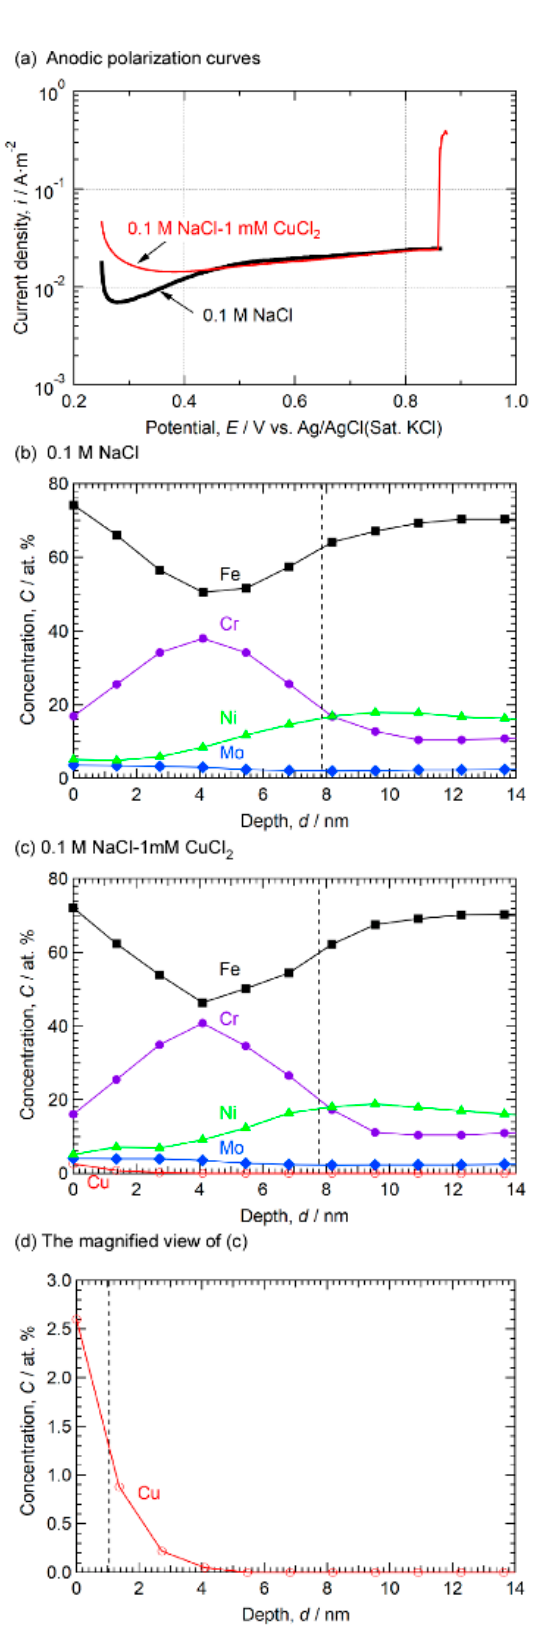
Figure 6. ( a ) Anodic polarization curves polarized from 0.25 to 0.86 V in 0.1 M NaCl and 0.1 M NaCl-1 mM CuCl 2 . Composition depth profiles of the surfaces for the specimens polarized ( b ) in 0.1 M NaCl and ( c ) in 0.1 M NaCl-1 mM CuCl 2 . ( d ) Magnified view of ( c ).